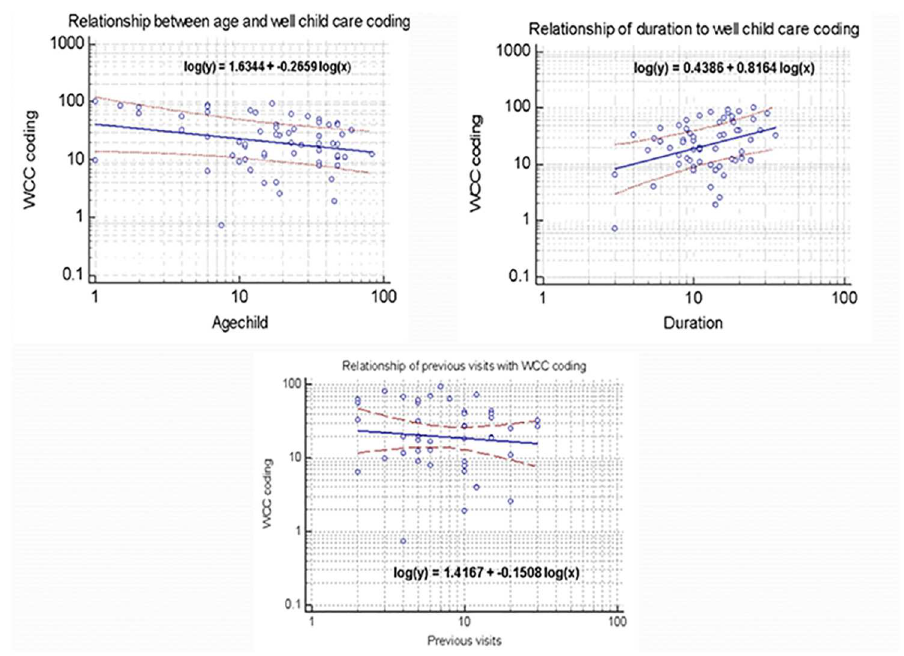
Fig 3. Regression analysis results for Well-Child care coding and important